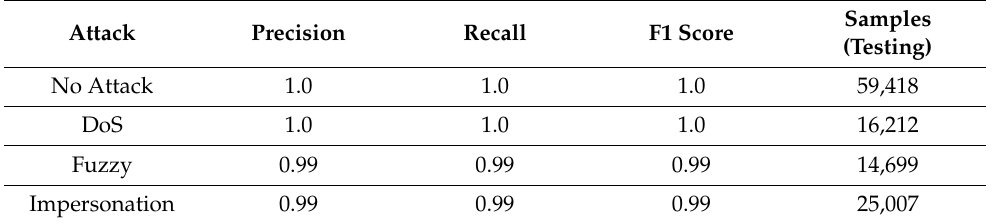
Figure 7. Confusion Matrix of DT (Dataset 1). Table 4. Detection performance of DoS, fuzzy, impersonation, and attack-free for DT (Dataset 1).